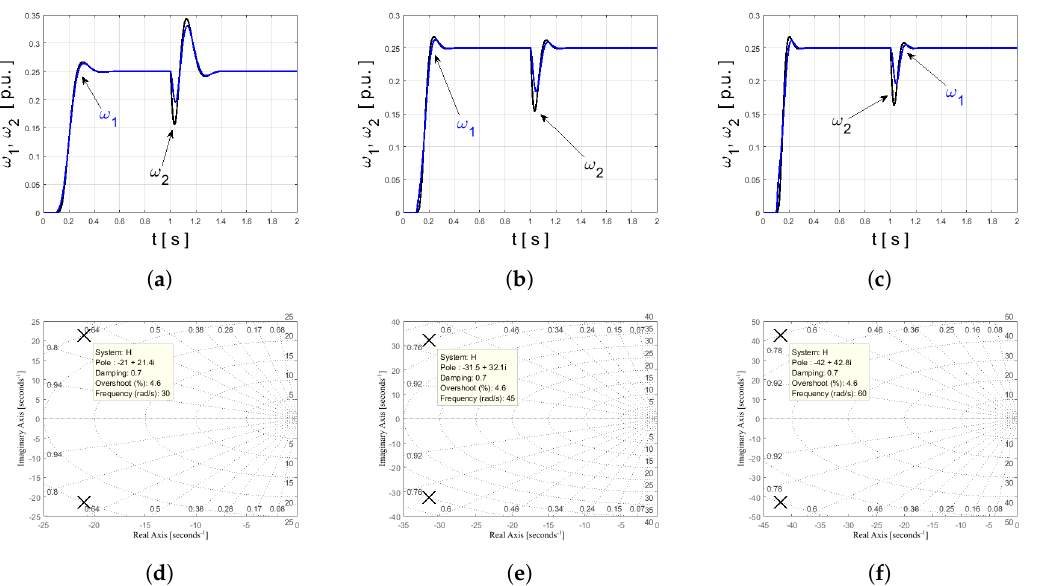
Figure 4. An influence of locus position on dynamics of transients: ( a , d ) ω 0 = 30 s − 1 and ξ r = 0.7; ( b , e ) ω 0 = 45 s − 1 and ξ r = 0.7; ( c , f ) ω 0 = 60 s − 1 and ξ r = 0.7.